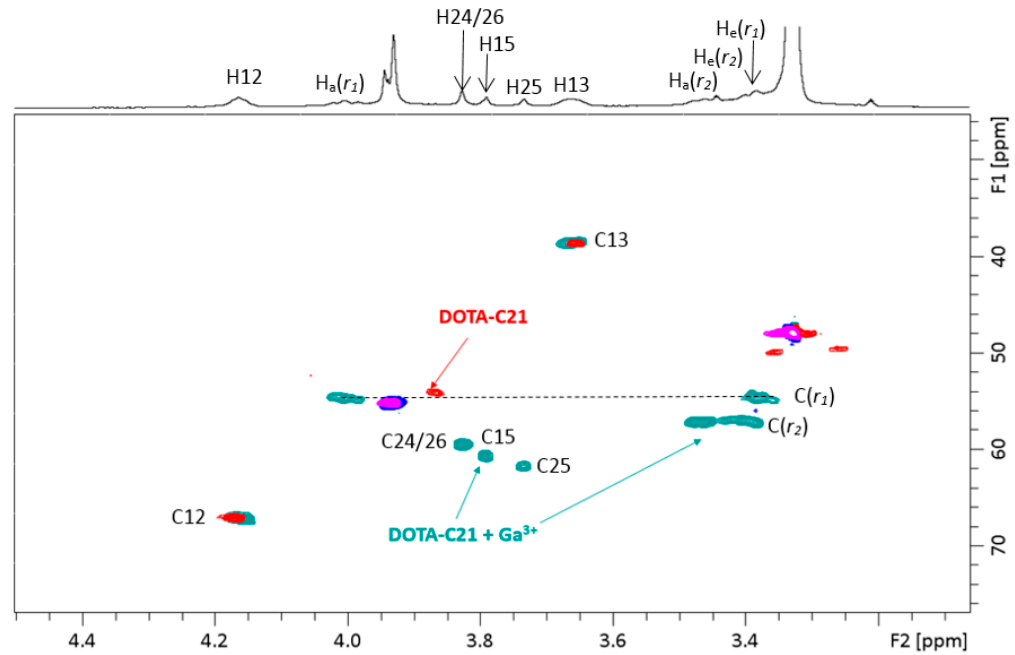
Figure 2. Aliphatic region overlap of 1 H-, 13 C-HSQC-NMR spectra of DOTA-C21 (red (CH 2 ) and purple (CH/CH 3 )) and Ga-DOTA-C21 (green (CH 2 ) and blue (CH/CH 3 )). All the spectra were acquired in MeOD- d 4 at 25 °C ([DOTA-C21] = 0.63 mM). Atom numbering refers to Figures 11 and 12.